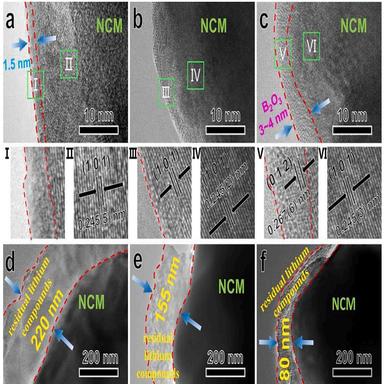
High-resolution TEM (HRTEM) images of (a) NCM-WT, (b) NCM-HT, (c) NCM-BCT, (d) 8NCM-WT, (e) 8NCM-HT, (f) 8NCM-BCT, respectively.